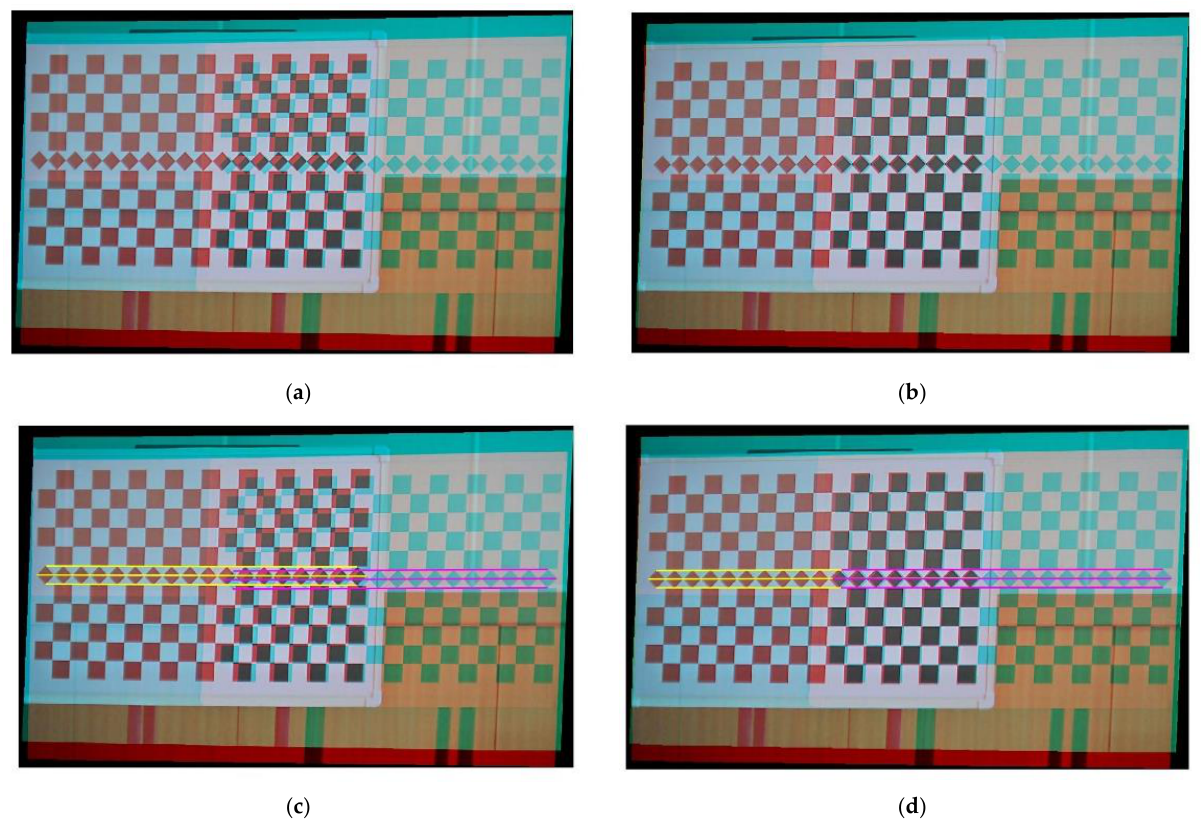
Figure 21. The error between lines and vertex of diamonds based on distortion calibration: ( a ) Rectify of the original image, ( b ) rectify of the calibrated image, ( c ) lines that are made using diamonds on the original image, and ( d ) lines that are made using diamonds on the calibrated